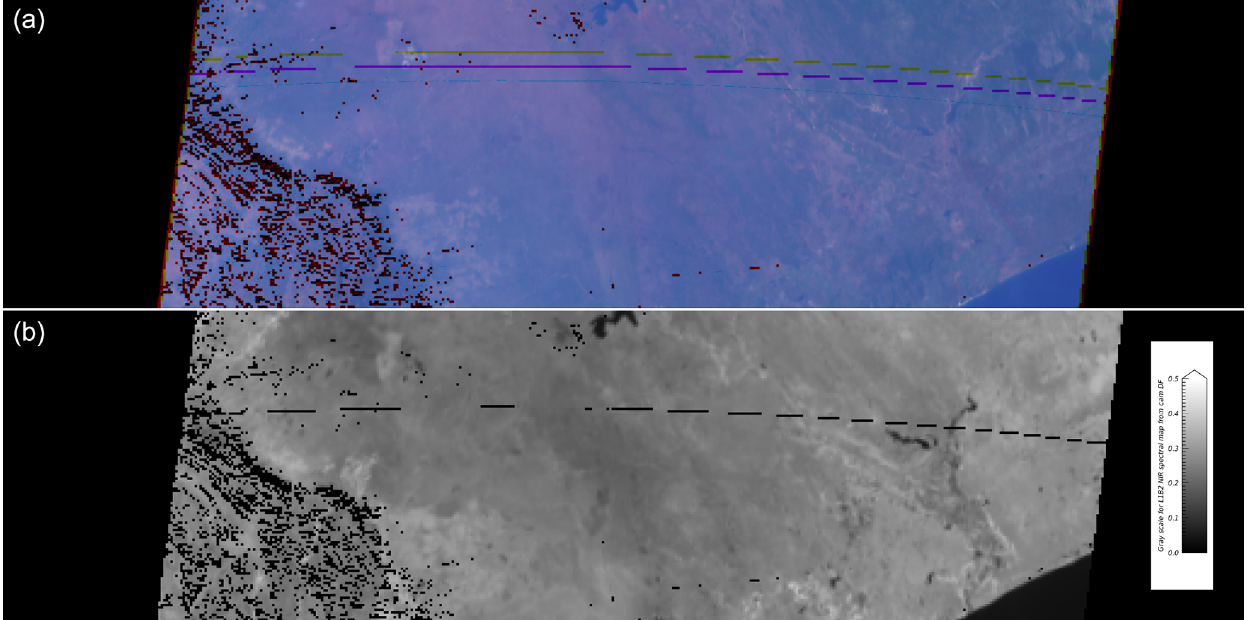
Figure 2. (a) Example of the effect of missing lines in a multispectral product, here an RGB composite of the red, green and blue spectral bands for the L1B2 terrain-projected G LOBAL M ODE Brf data for the same DF camera case exhibited in Fig. 1. The top (yellow), middle (magenta) and bottom (light cyan, barely visible because of the general bluish tone of the image) lines correspond to the missing data in the blue, green and red spectral bands, respectively. This image was generated by first replicating the low-resolution blue and green pixels so as to match the resolution of the red band and then creating the composite image at the full spatial resolution. (b) Map of the NIR Brf of the same DF camera. The linear dimensions are the same as in Fig. 1. The three RGB spectral channels are stretched from 0.0 to 0.35 for the purpose of generating the color image, while the NIR data are stretched between 0.0 and 0.5.